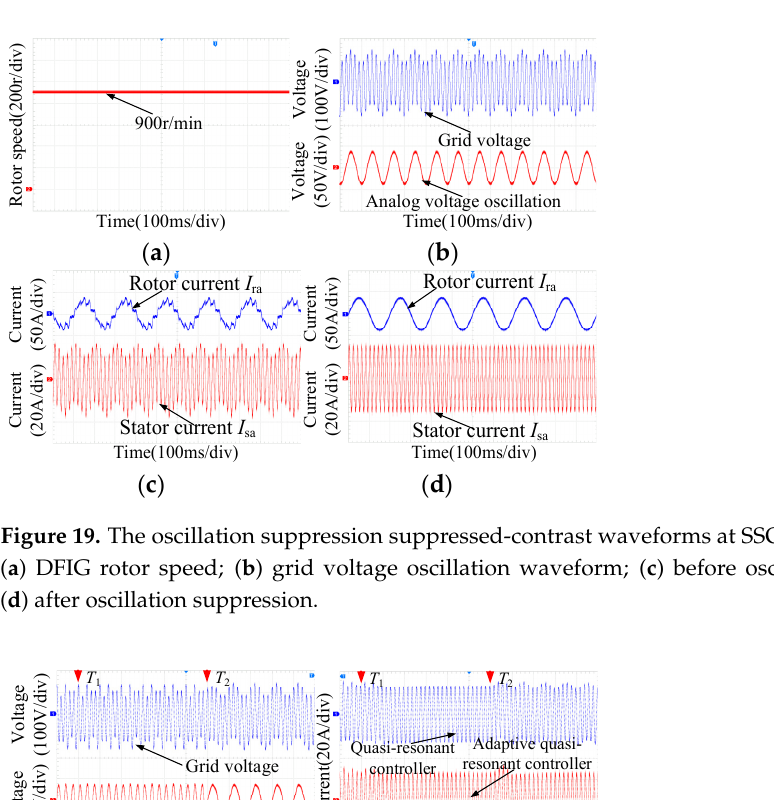
Figure 18. The oscillation suppression suppressed-contrast waveforms at SSO frequency of 20 Hz: ( a ) DFIG rotor speed; ( b ) grid voltage oscillation waveform; ( c ) before oscillation suppression; ( d ) after oscillation suppression.